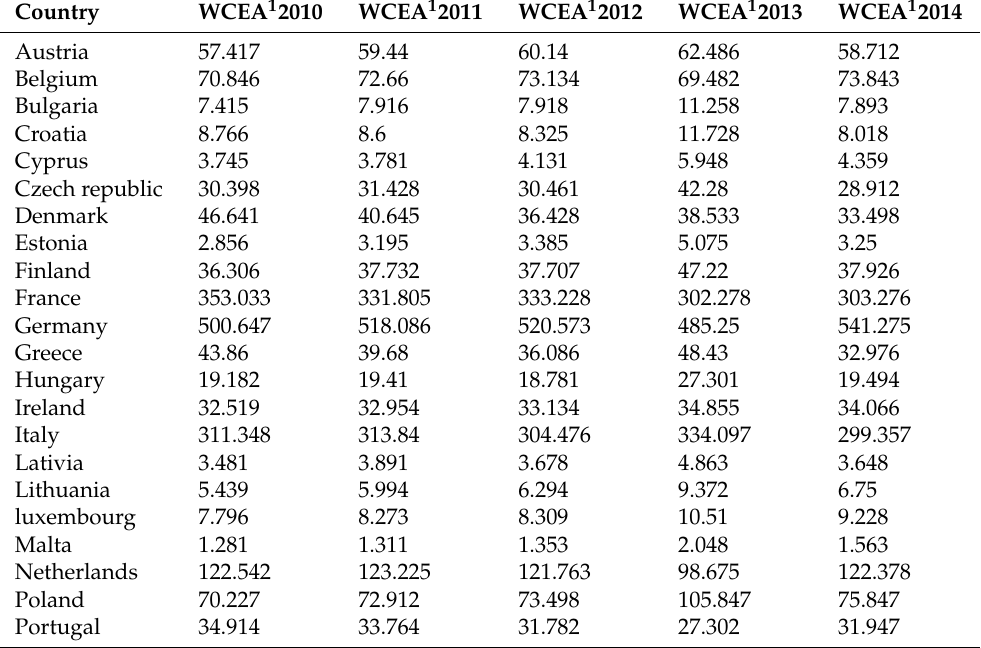
Table A3. Allocation vectors provided by the WCEA solution with GDP as a unique weight (denoted by WCEA 1 ) for each year in the interval 2010–2014 (values are in millions of tons of CO 2